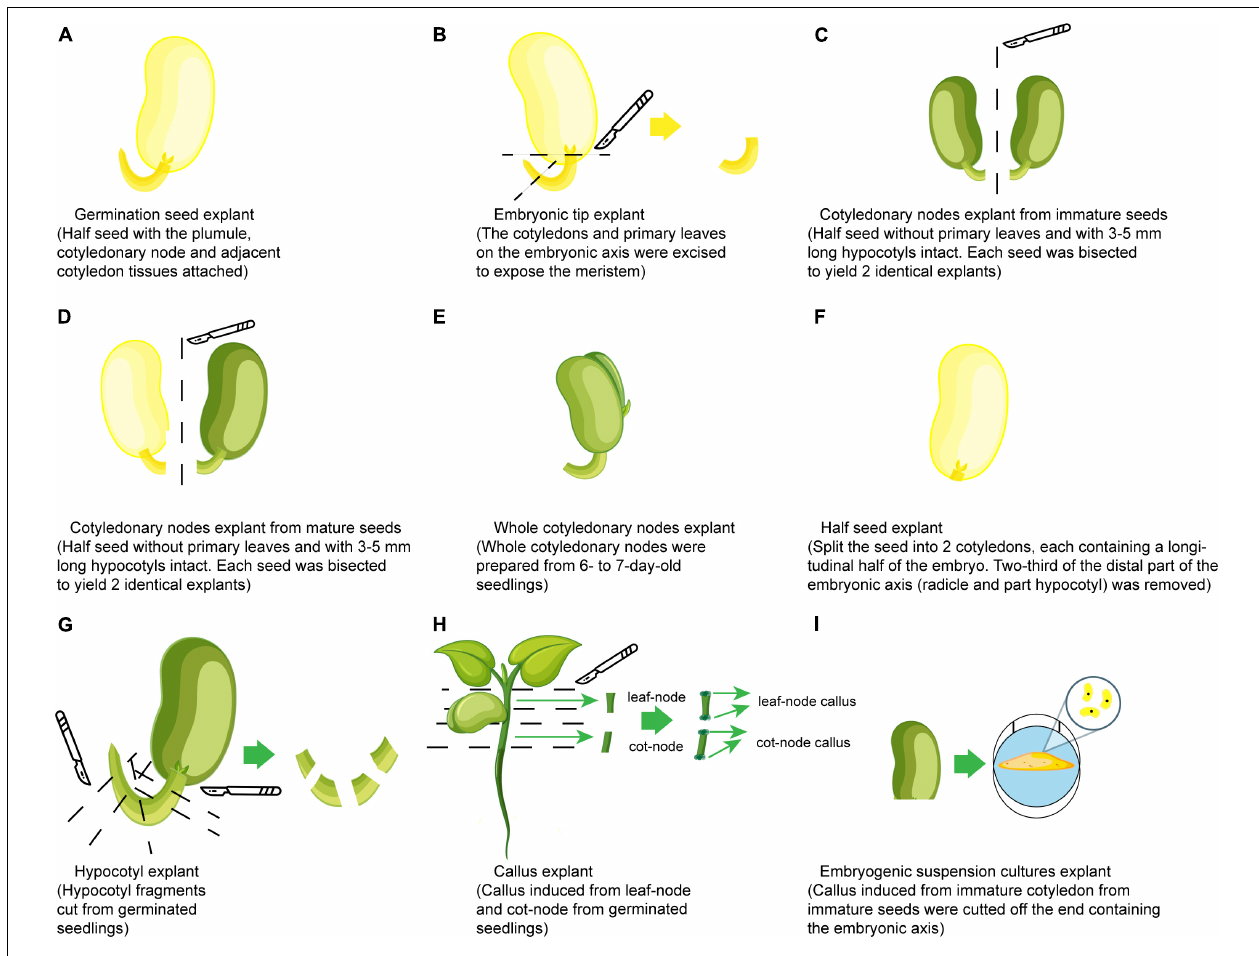
FIGURE 3 | Types of explants used for soybean transformation. (A) Germination seed. (B) Embryonic shoot tips. (C) Cotyledonary nodes from immature seeds. (D) Cotyledonary nodes from mature seeds (yellow cotyledon means use cotyledon directly from mature seed; the green one means use mature cotyledon